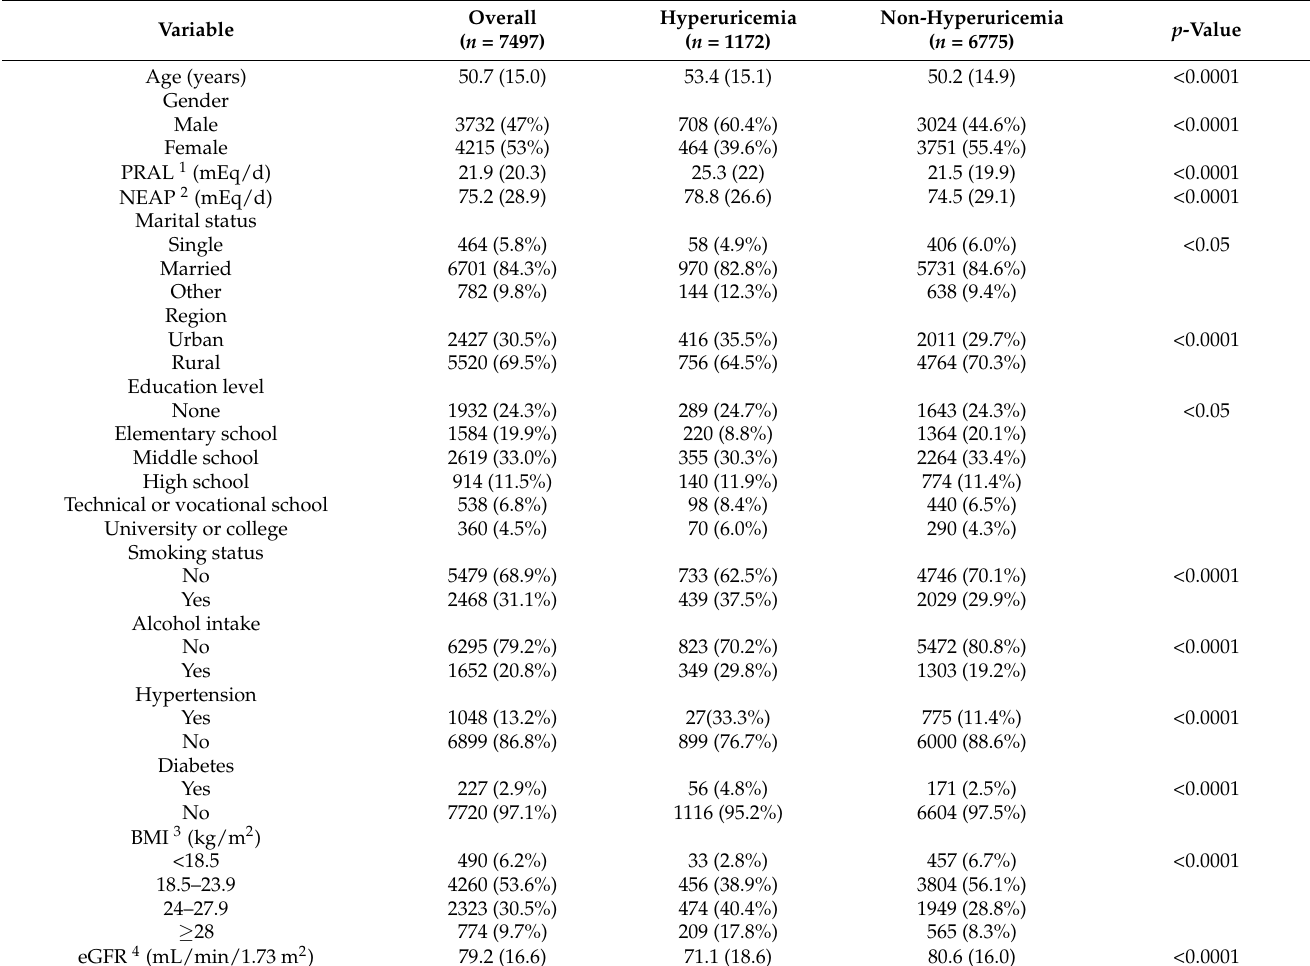
Table 1. Subject characteristics based on hyperuricemia status.